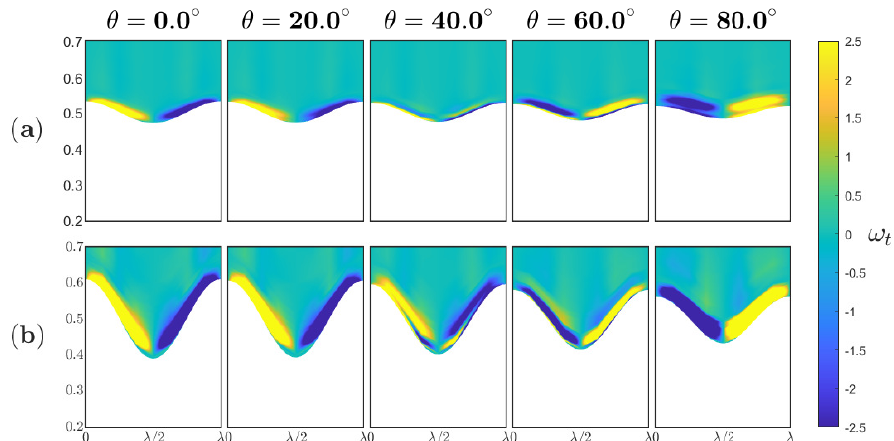
Figure 15. Contours of mean tangent vorticity ω t over the r – θ plane for the two wavy models, A03 ( a ) and A11 ( b ), for increasing values of θ . Refer to Figure 14 (left schematic) for the planes and coordinates adopted. As a spanwise periodic phenomenon, the spatial average referring to the repetition of wavelengths is calculated and exhibited here as a single wavelength.